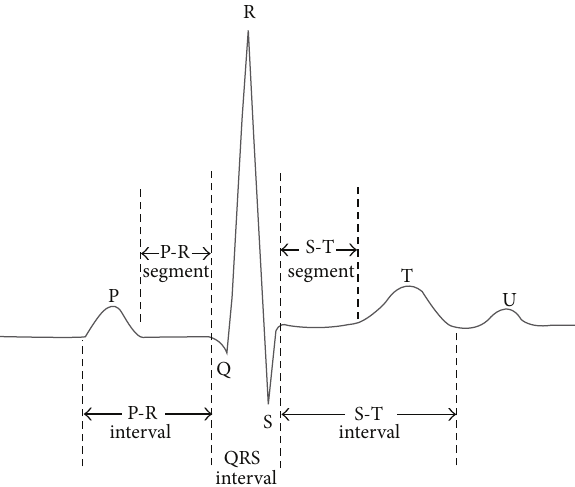
Figure 3: A typical one-cycle ECG tracing (adapted from http://www.ni.com/white-paper/app/largeimage?lang=cs& imageurl=%2Fcms%2Fimages%2Fdevzone%2Ftut%2F2007-07-09 141618.jpg).